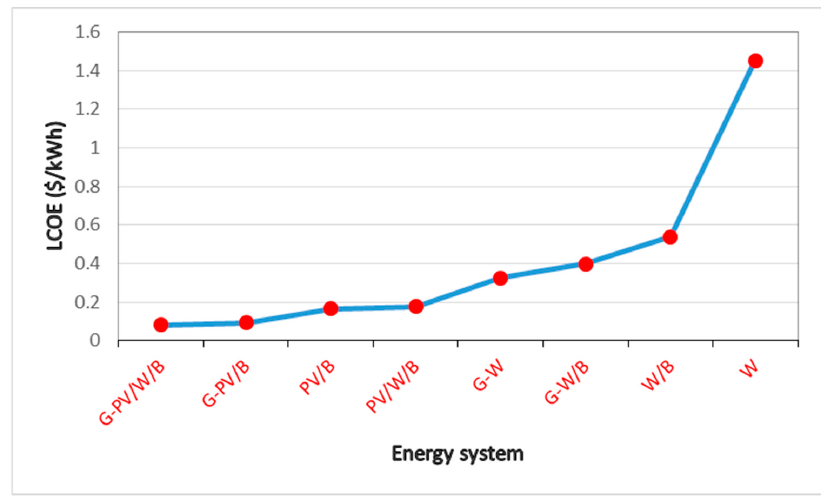
Figure 8. Comparison of the studied systems focusing on their electricity cost. The environmental analysis of the ES studied, described in Table 11 and in Figure 9, shows that the least polluting system is the stand-alone Wind system (1621.5 kgCO 2 /year), followed by the Grid-Wind system (6430.4 kgCO 2 /year), the Wind/Battery system (10,252.6 kgCO 2 /year), the PV/Wind/Battery system (11,439 kgCO 2 /year), the Grid- Wind/Battery system (13,139.7 kgCO 2 /year), the Grid-PV/Wind/Battery system (14,888.4 kgCO 2 /year), the PV/Battery system (14,892.5 kgCO 2 /year), and the Grid-PV/Battery sys- tem (16,916.6 kgCO 2 /year). The obtained results show that the most polluting components are the battery and grid. Table 11. Comparison of the studied systems based on their CO 2 emissions.